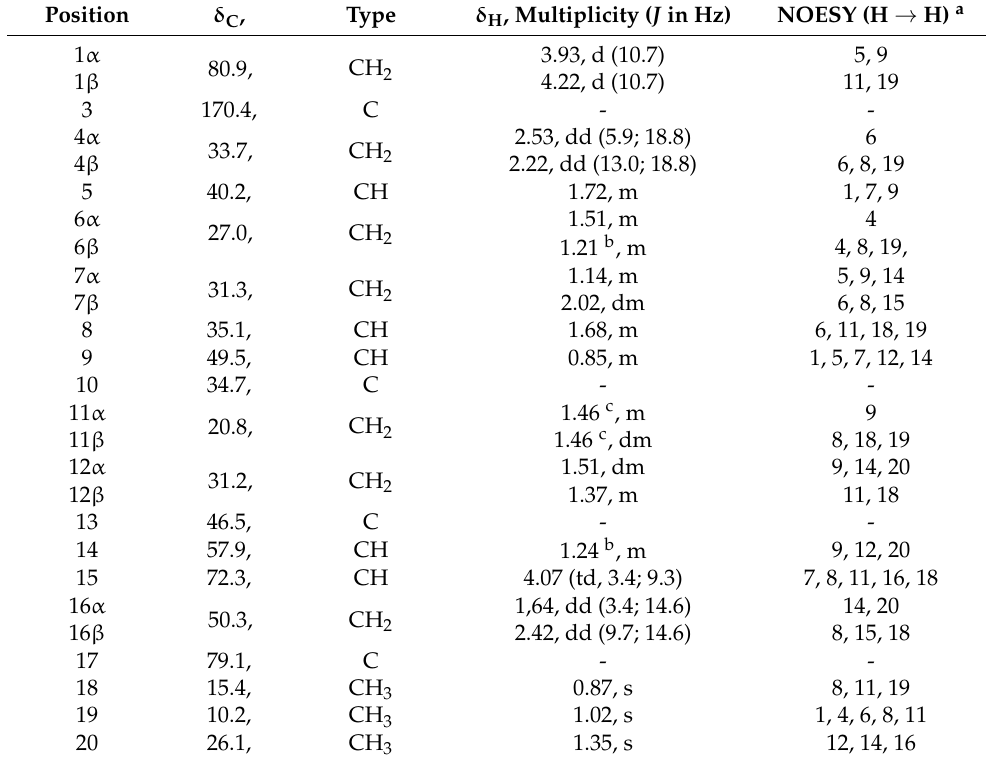
Table 2. Spectroscopic data of 15 α -hydroxyoxandrolone ( 5 ) *. Position δ C , Type δ H , Multiplicity ( J in